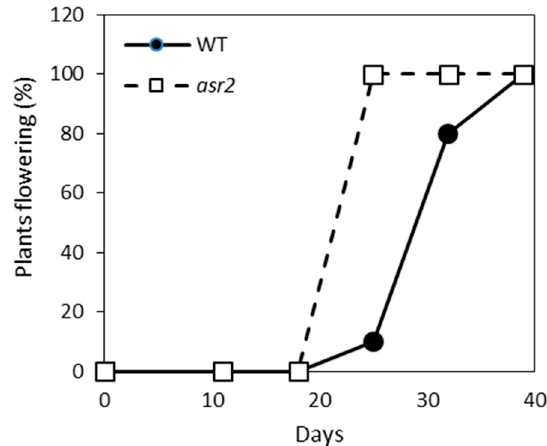
Figure 5. asr2 has an early flowering phenotype. The number of flowering wild-type (WT) and asr2 plants were measured over a 40-day time-course ( n = 10). Similar results were obtained in an independent experiment.